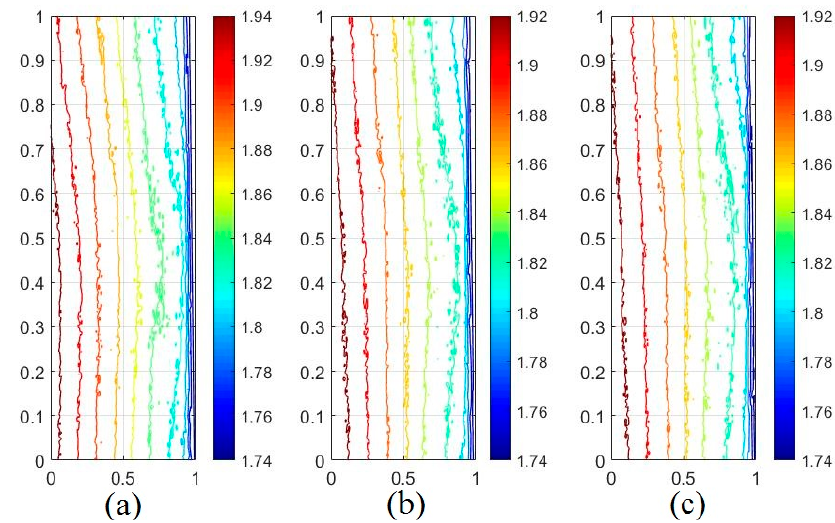
Figure 15. Depth contour of S2 (unit: cm): ( a ) F = 200N, ( b ) F = 800N, ( c ) F = 1200N.